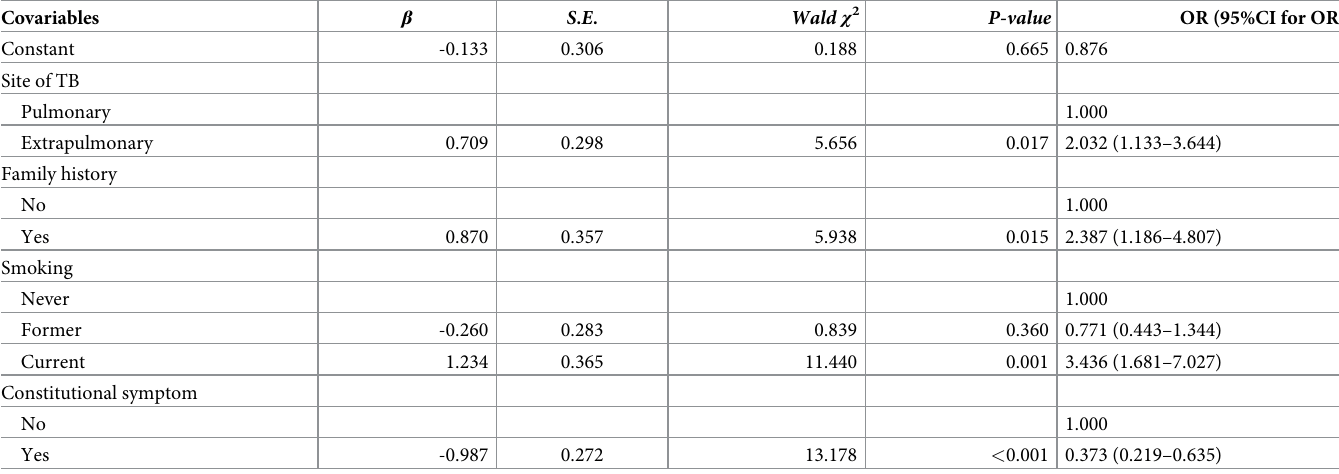
Table 6. Predictors of MDR-TB patients registered for treatment in Liberia in 2015 (n = 337). Covariables